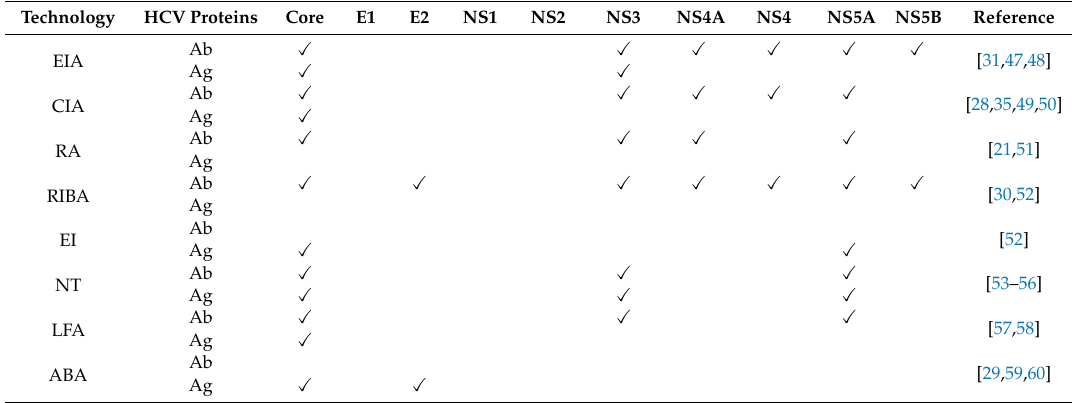
Table 2. The technologies used for the detection of HCV proteins either as HCV antigen or the anti-HCV antibodies for the HCV